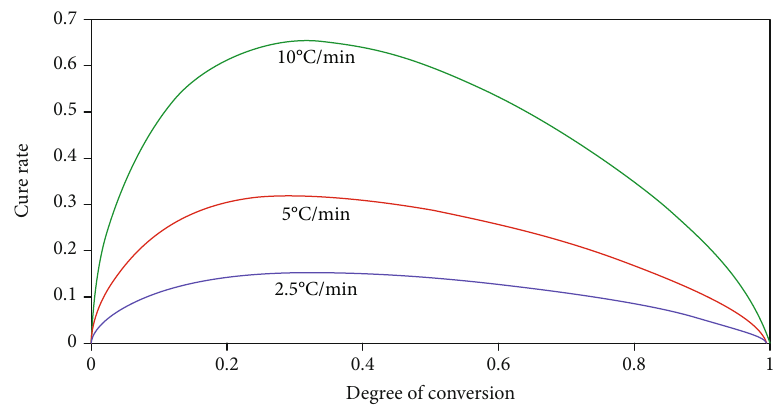
Figure 11: The cure rate versus degree of conversion for uncured EP-PEG-NS. ff erent conversions of EP-PEG-NS. Table 8: E a at di